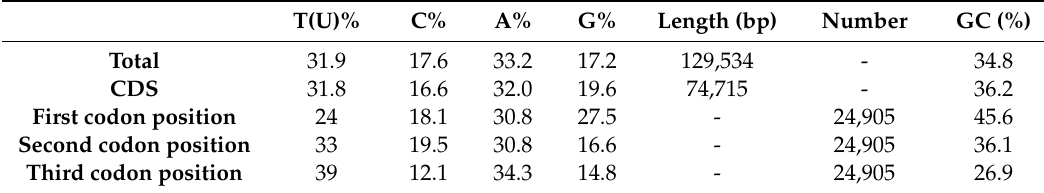
Table 3. Nucleotide composition of the F. hodginsii cp genome.